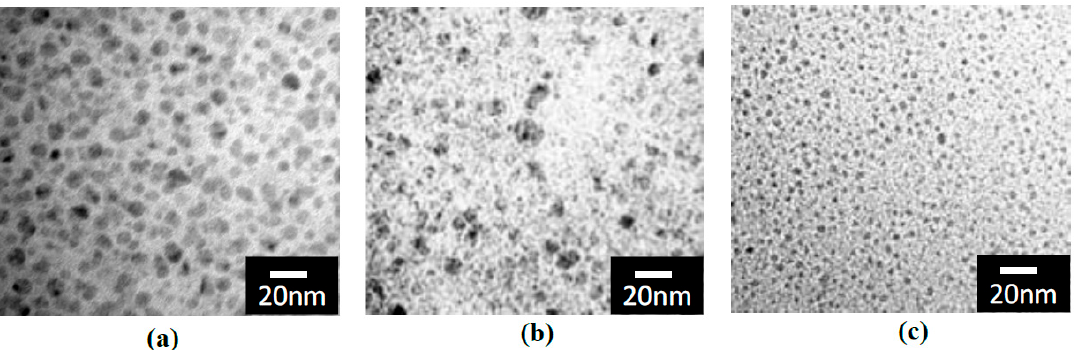
Figure 5. TEM images of the synthesized CuNPs with the flow rate of ( a ) 0.0001 mL/min; ( b ) 0.02 mL/min; and ( c ) 0.04 mL/min.